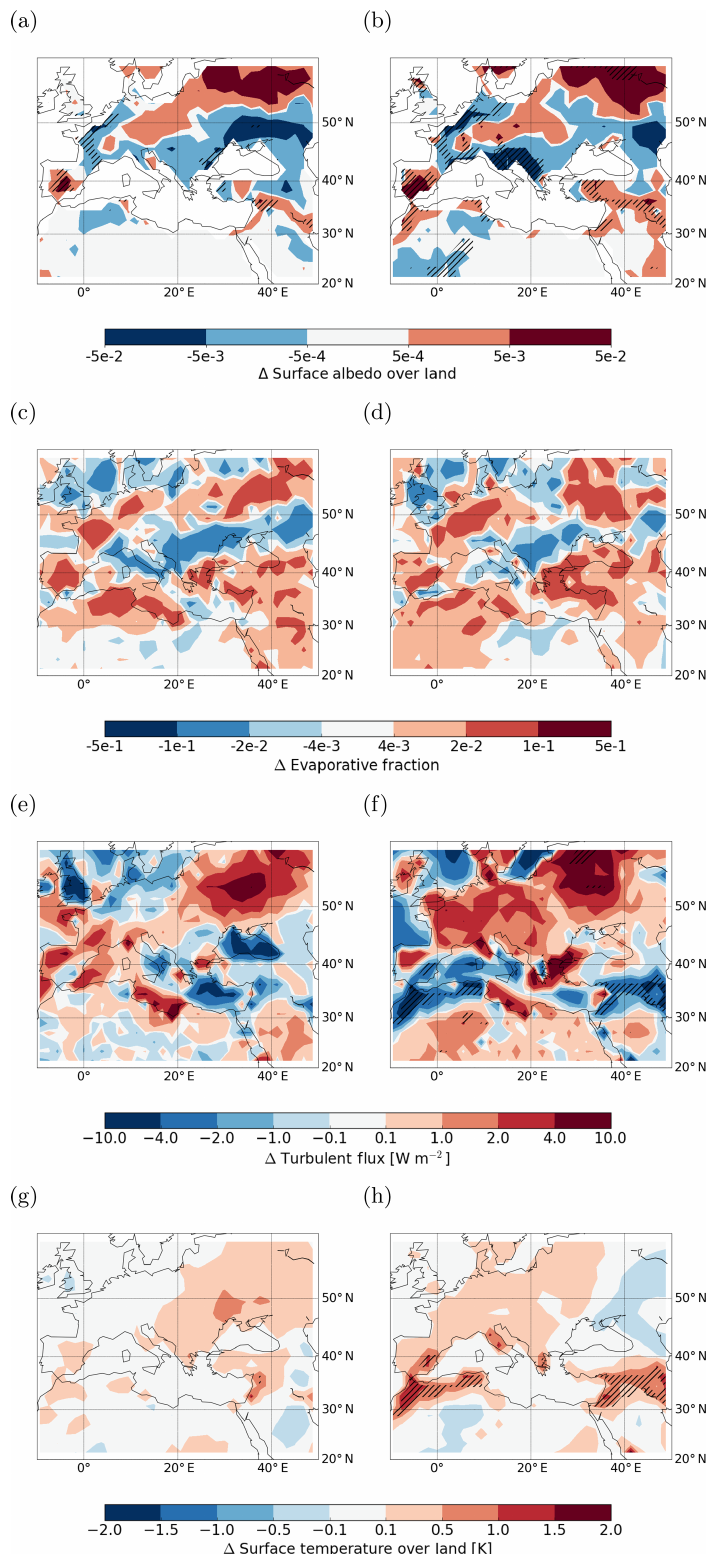
Figure 2. The impact of anthropogenic land cover change using HYDE11 (a, c, e, g) and KK11 (b, d, f, h) . Shown are changes in surface albedo over land (a, b) , evaporative fraction (c, d) , turbulent flux (e, f) , and land surface temperature (g, h) . Statistically significant changes (5% significance level; N = 20) are hatched. Note that the SSTs in the simulations are